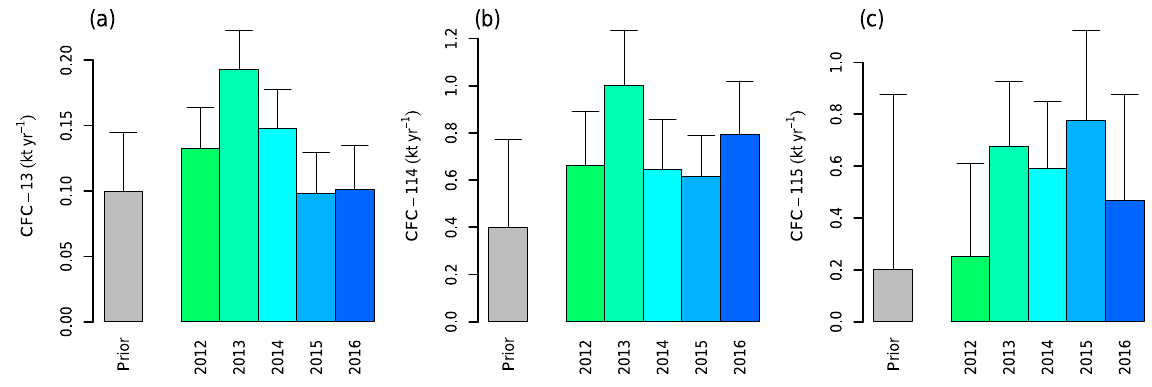
Figure 7. Total Chinese emissions of CFC-13 (a) , (cid:54) CFC-114 (b) , and CFC-115 (c) , estimated with the regional inversion. Uncertainties represent a 1 σ